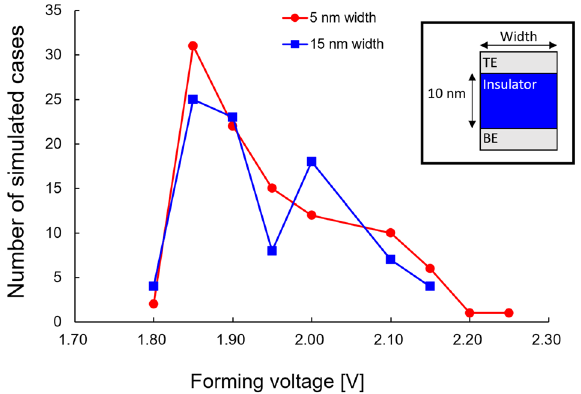
Figure 10. Comparison of switching uniformity for different cell widths and the same insulator thickness of 10 nm. The defect formation of energy of 4.5 eV was